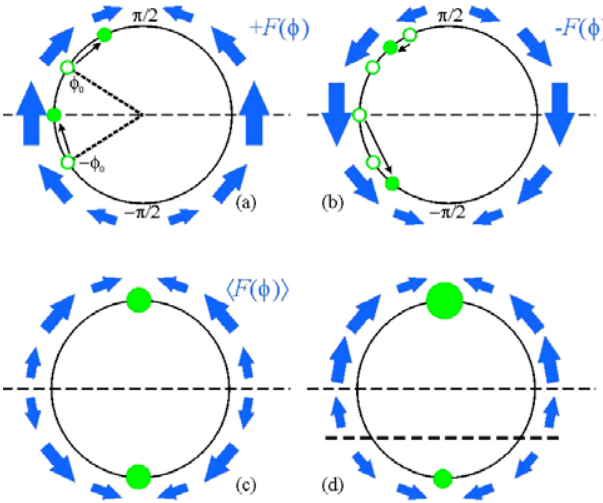
FIG. 2. (Color) Electron bunching in the case of the klystron- type profile of the electron-wave coupling factor: motion of particles over the Larmor orbit after the first, positive, push (a) and the second, negative, push (b) from the input wave, sym- metrical averaged bunching force (c), and nonsymmetrical elec- tron bunching